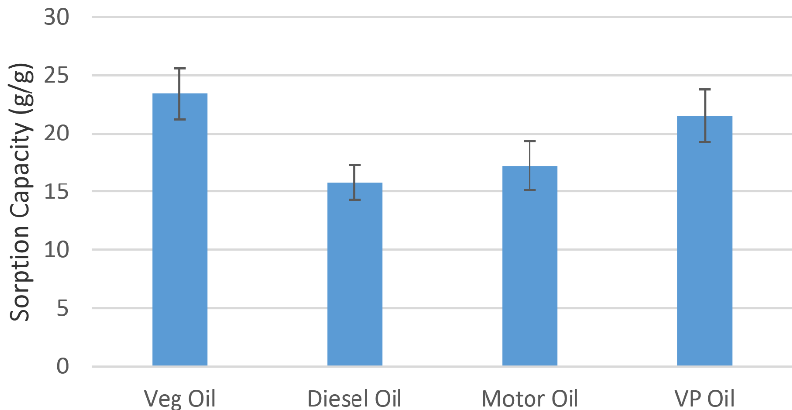
Figure 8. Sorption capacities of fabricated sorbents for various oils.